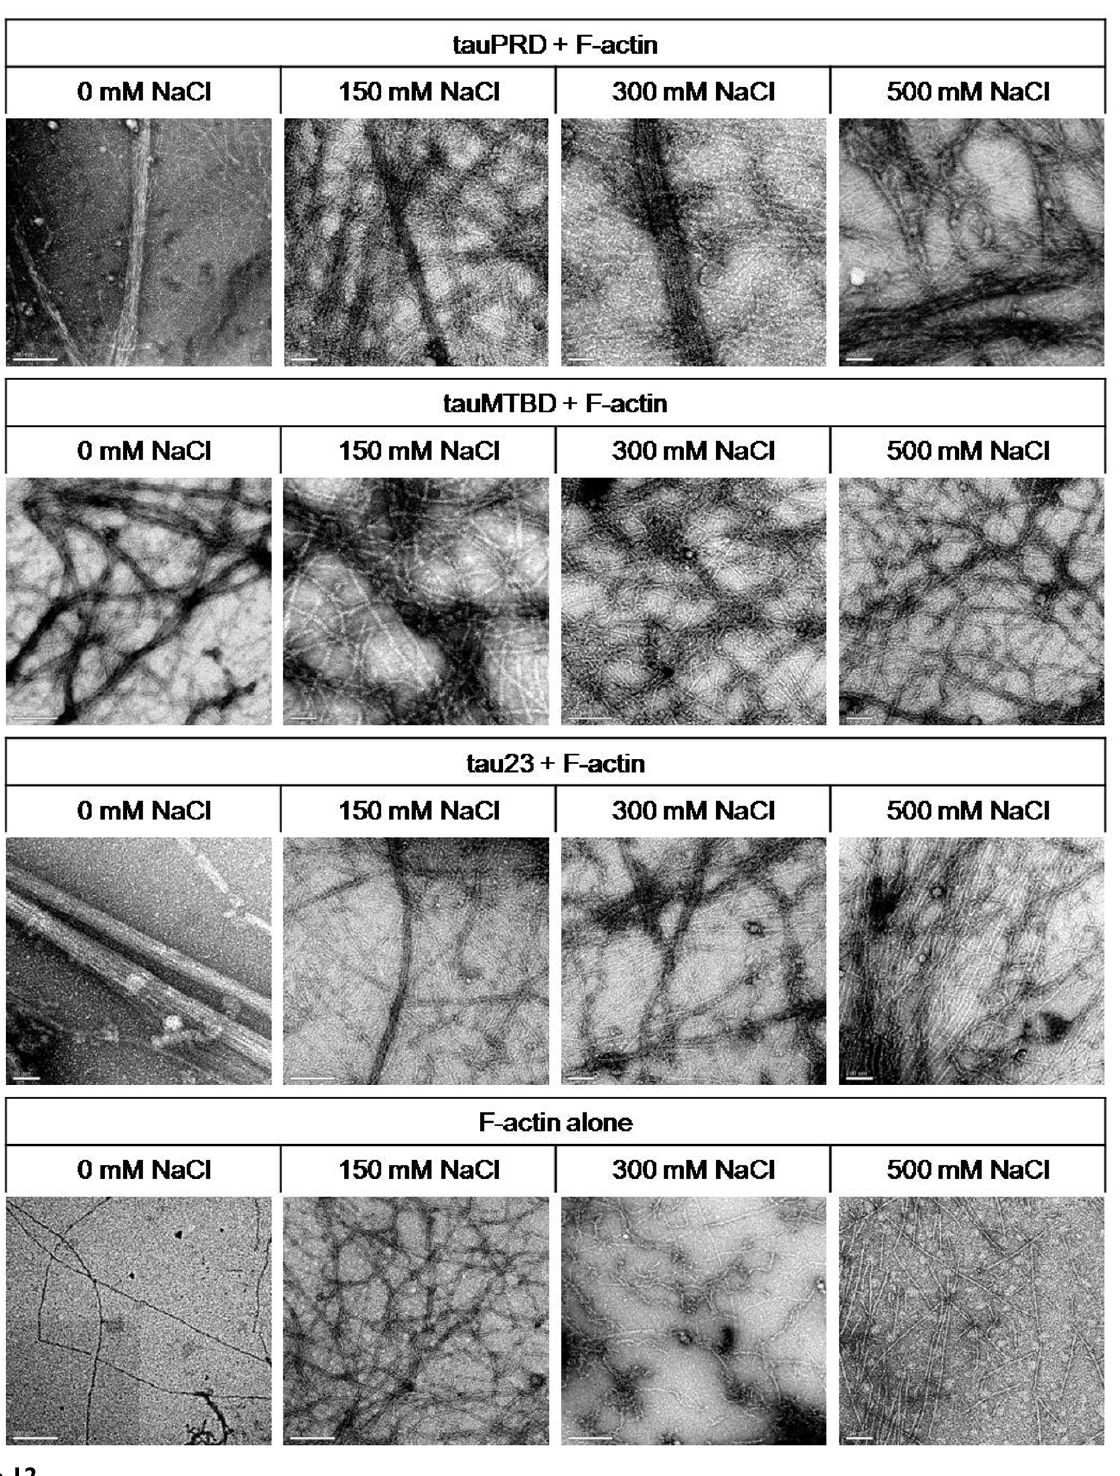
Figure 12 Electron microscopy images of F-actin incubated with tauPRD in the presence of NaCl at different concentra- tions . Conditions were the same as those in Figure 7, except that different concentrations of NaCl were added to the reaction mixtures of F-actin and tauPRD (tau or tauMTBD) as indicated. The bar in each panel represents 200